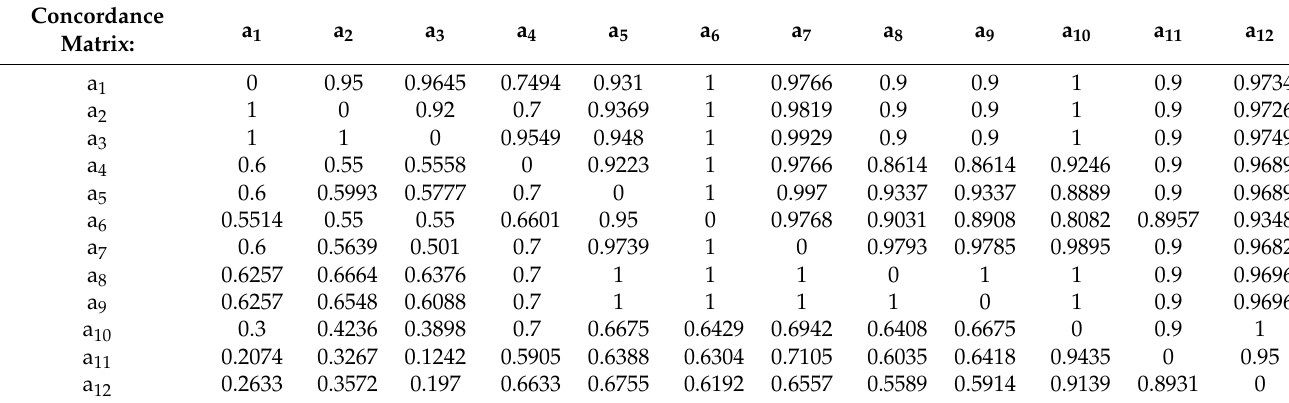
Table 6. Concordance matrix C values.